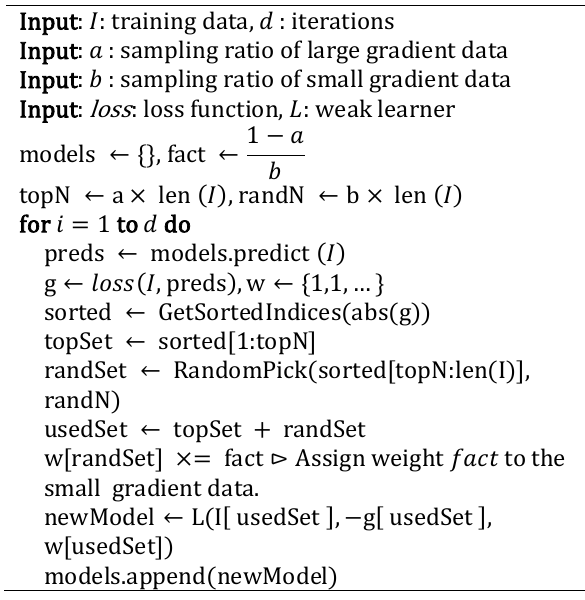
Figure 1. Level-wise tree growth